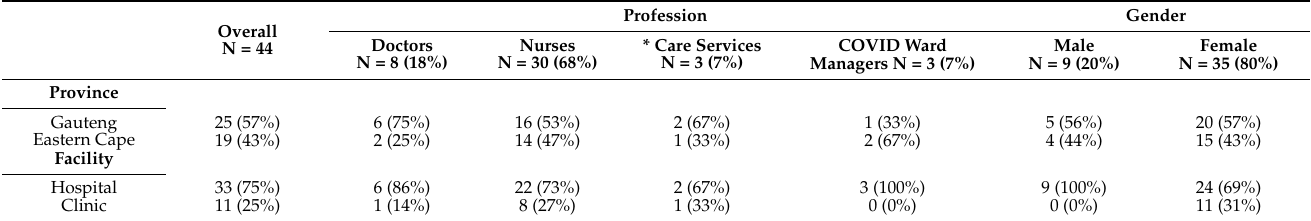
Table 1. Health care workers demographic characteristics (N =